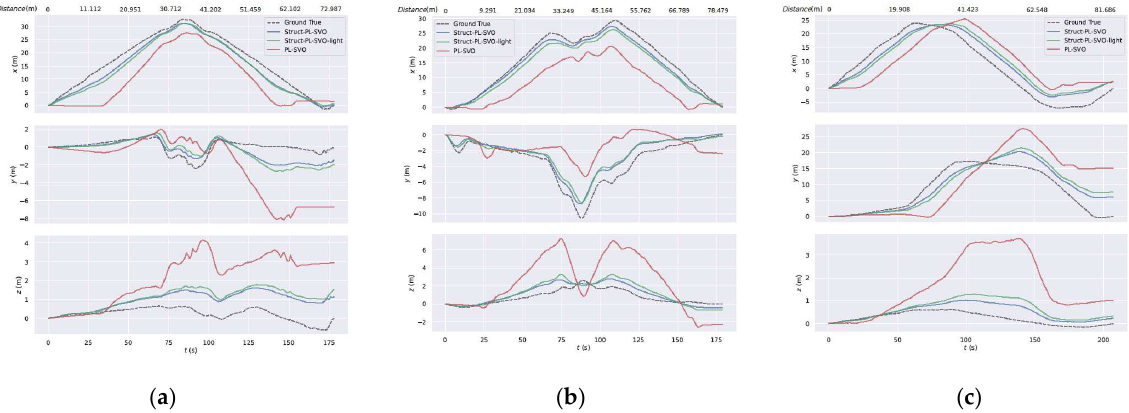
Figure 11. The aligned trajectories with Struct-PL-SVO (in blue), Struct-PL-SVO-light (in green), and PL-SVO (in red) from the ceiling dataset (ground truth in gray). ( a ) The trajectory estimated in Floor 3 sequence 1. ( b ) The trajectory estimated in Floor 1 sequence 3. ( c ) The trajectory estimated in the Parking lot sequence 5.